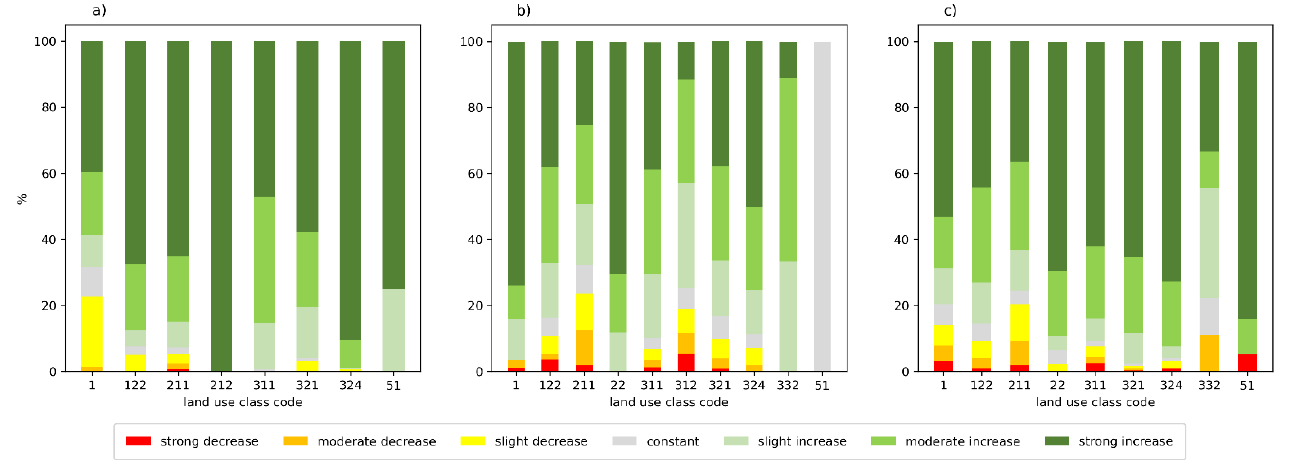
Figure 8. Percentage distribution of vegetation evolution classes vs. land use class code: ( a ) Aia dei Monaci, ( b ) Montegrosso-Pallareta, ( c ) Vallone Calabrese. Land use class codes are described in